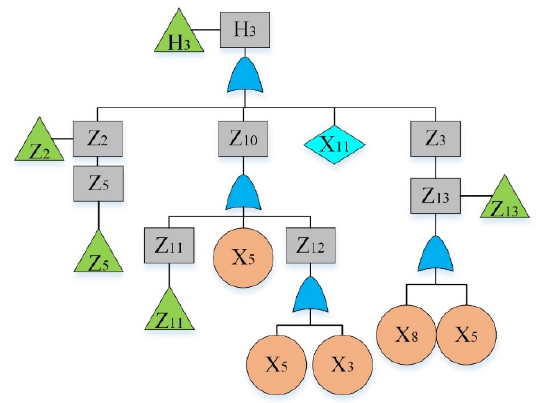
Figure 4. Fault tree of a hydraulic system: sub-tree II.